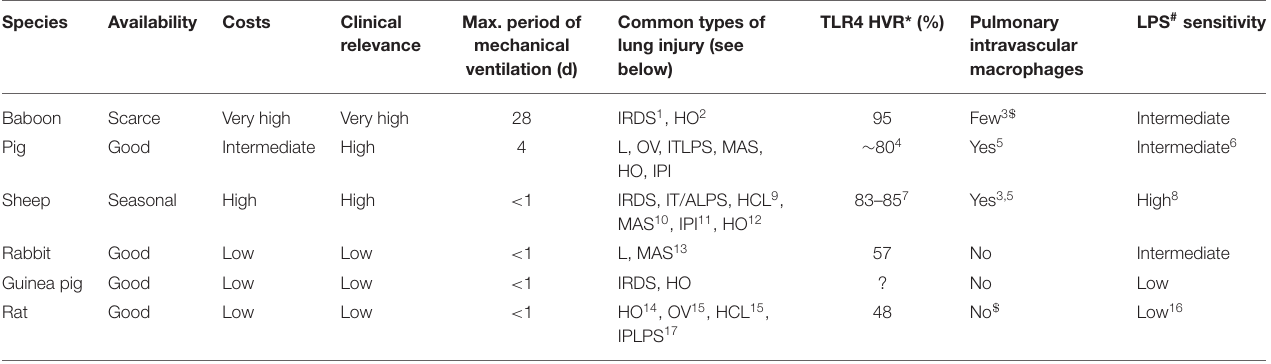
TABLE 13 | Newborn animal models of acute respiratory distress syndrome (NARDS) involving mechanical ventilation.